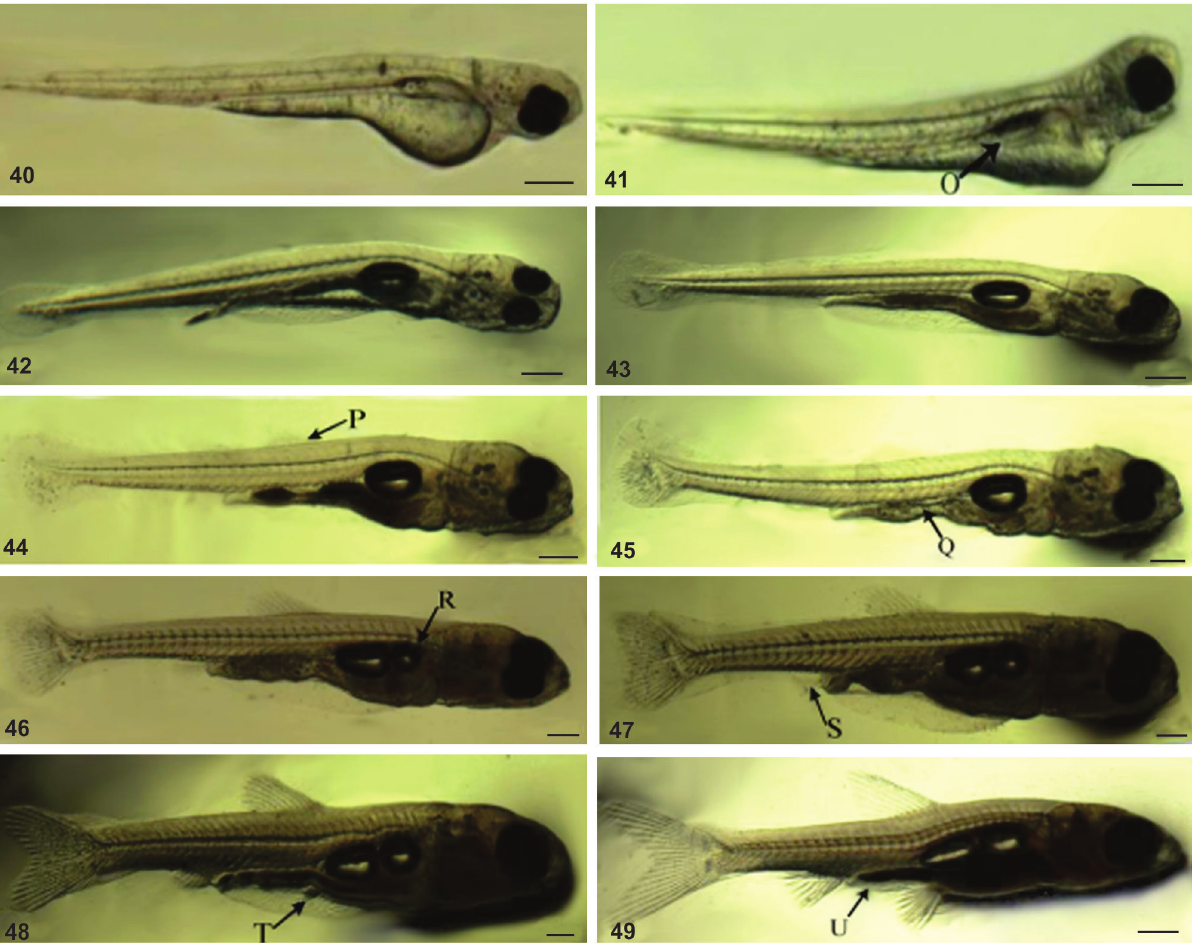
Figures 40–49. The larval development of Pseudorasbora parva : (40) One day after hatching (DAH); (41) Two DAH (O, the first